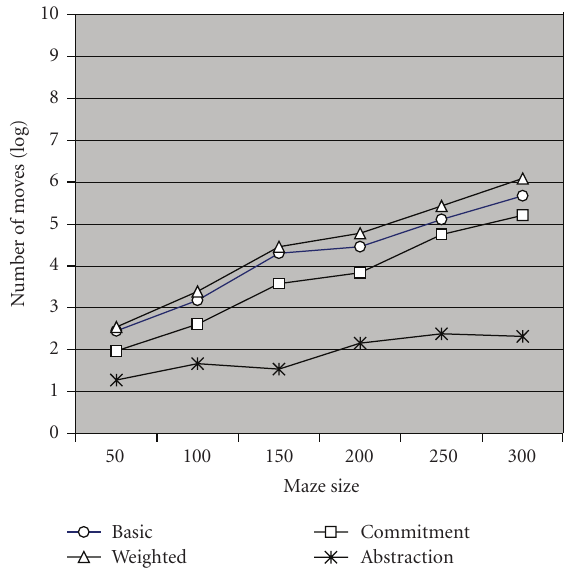
Figure 5: Target acquisition moves